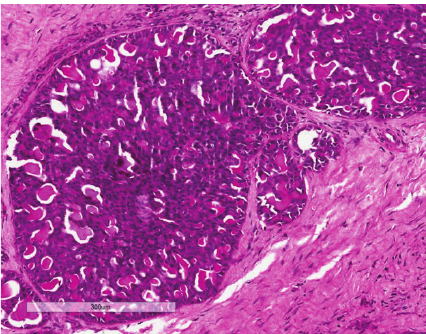
Figure 1: MASC displaying microcystic pattern of growth and these spaces are filled with pink colloid-like material (H&E, 200x magnification). Figure 2: MASC displaying microcystic pattern of growth with the spaces showing pink colloid-like